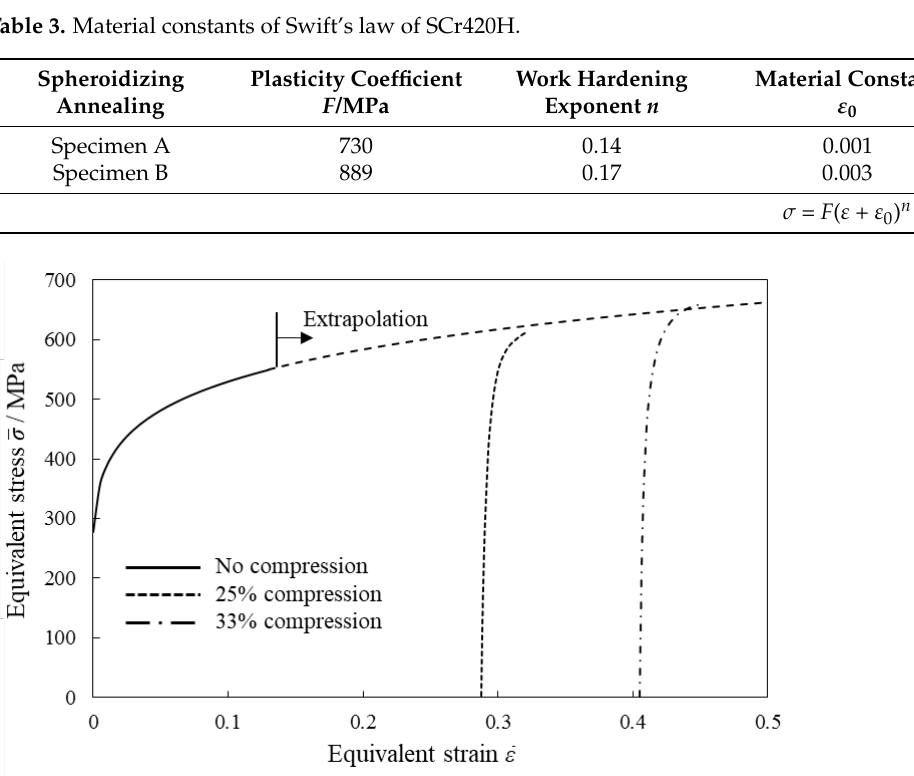
Figure 7. Simulation model of tensile test (Notched round bar specimen No. 4 in Table 2).